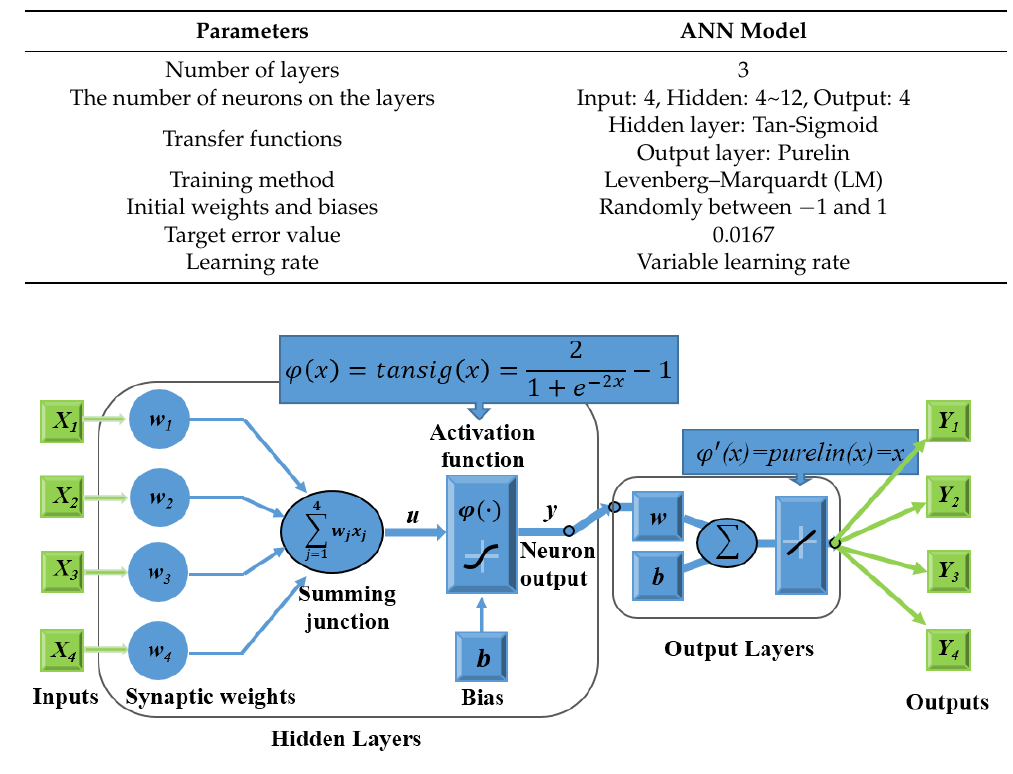
Figure 5. The mathematical model of the ANN.